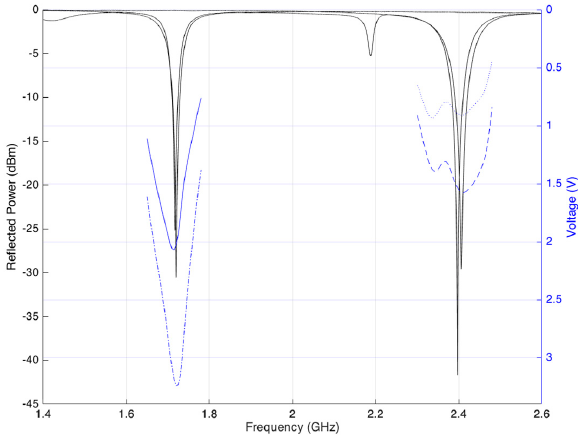
Figure 8. Optimal operational frequency.